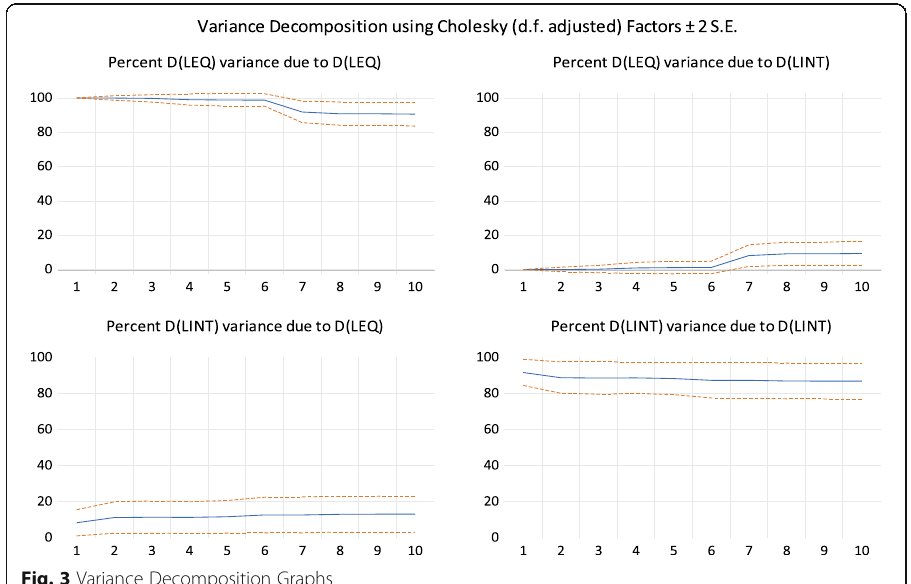
Fig. 3 Variance Decomposition